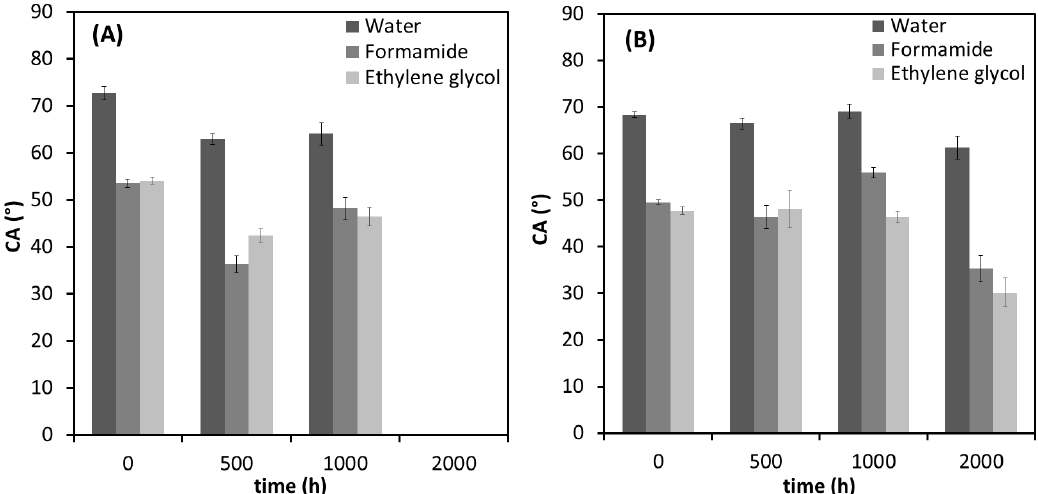
Figure 4. Contact angles (CAs) of water, formamide and ethylene glycol in ( A ) the PHBV and ( B ) the PHBV/TiO 2 as a function of increasing weathering exposure time.